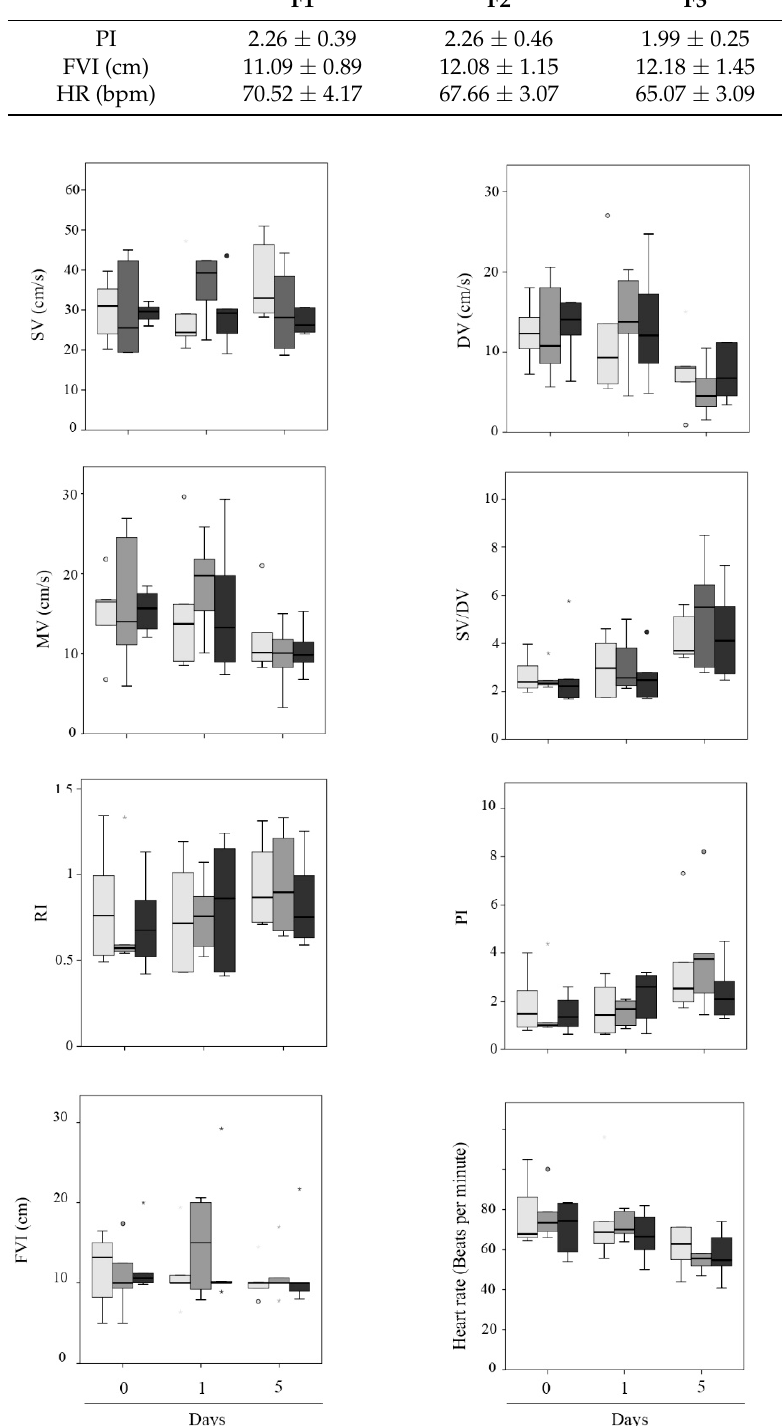
Figure 4. Box plot describing Doppler ultrasonography values of the uterine arteries’ blood flow at the three days of evaluation (D0, D1, and D5) analyzed by the type of seminal dose used (F1—light grey bars, F2—grey bars, and F3—dark grey bars). The statistical comparison was performed between seminal dose types (F1-F2-F3) on each day of analysis (D0, D1, and D5). No significant differences were observed ( p > 0.05). Small circles ( ◦ ) and asterisks (*) in the box plot represent outliers and extreme cases, respectively.